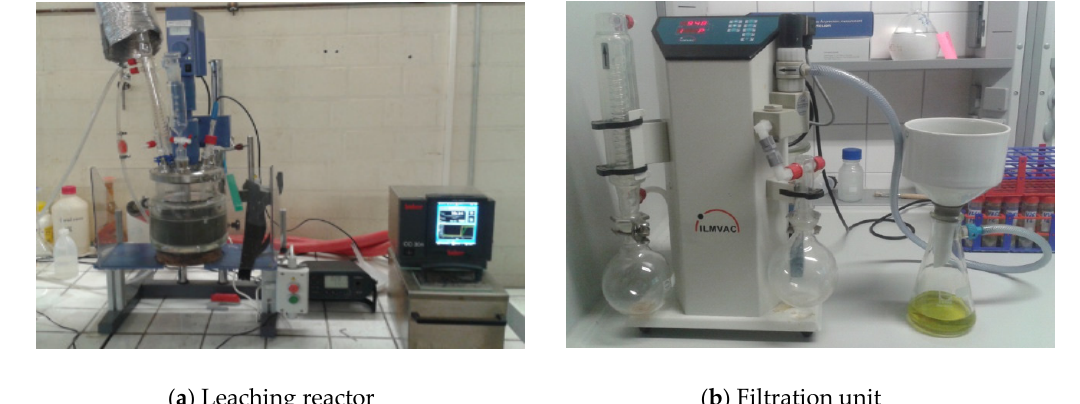
Figure 3. Leaching reactor and Filtration unit.